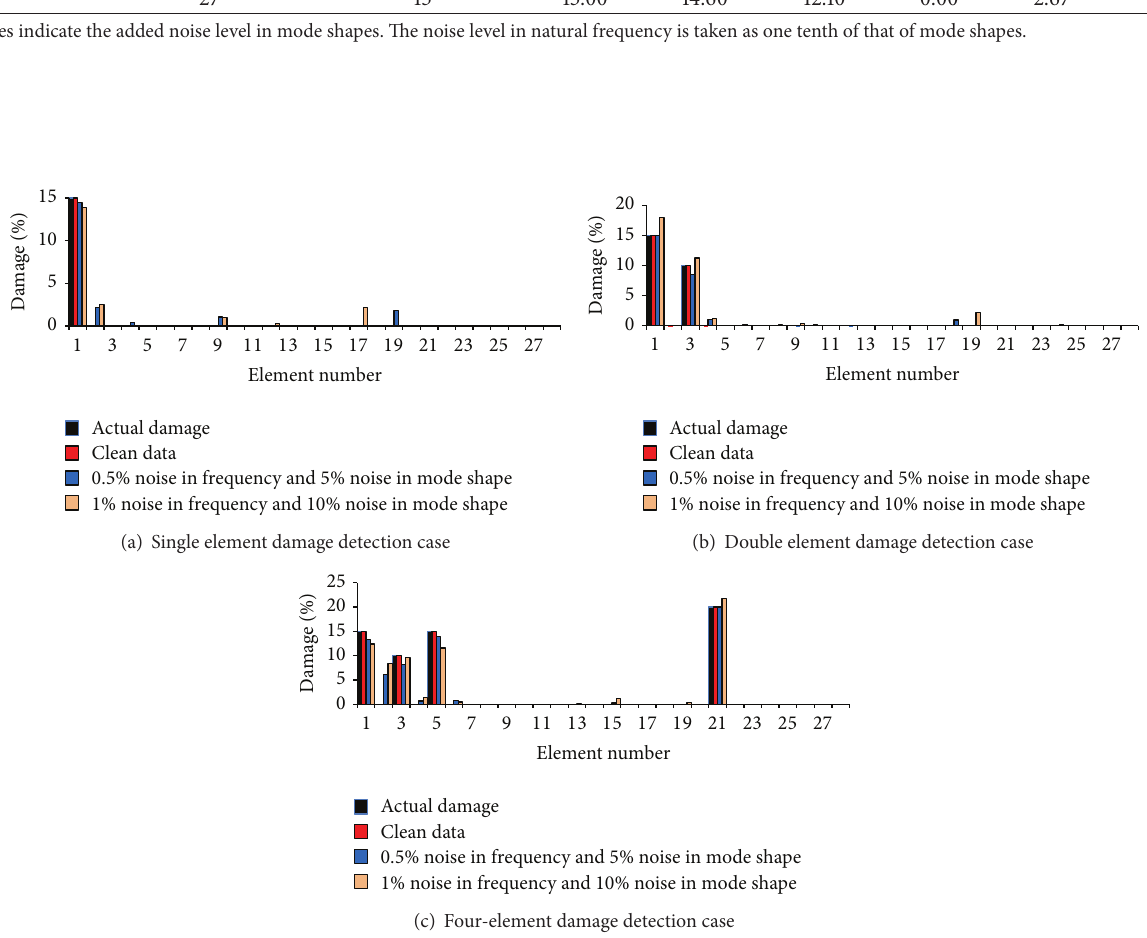
Figure 8: Damage detection results for 3-bay and 4-storey frame